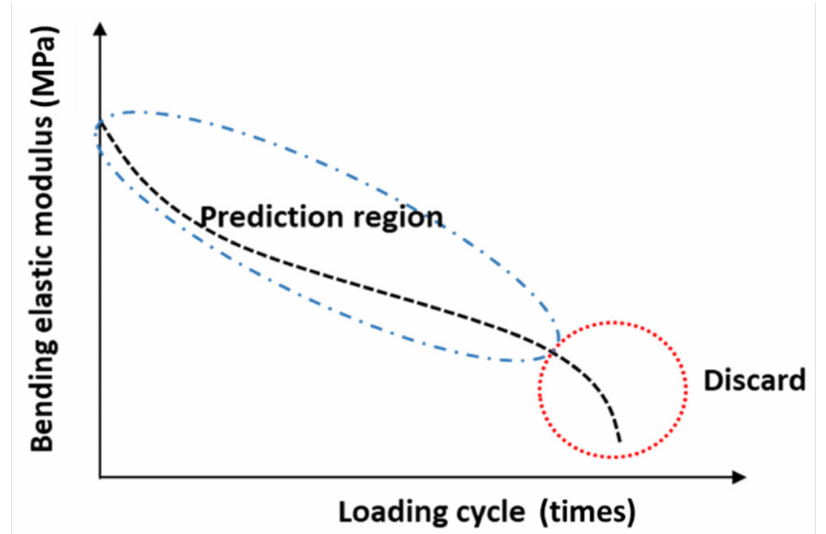
Figure 15. Development of bending elastic modulus in two